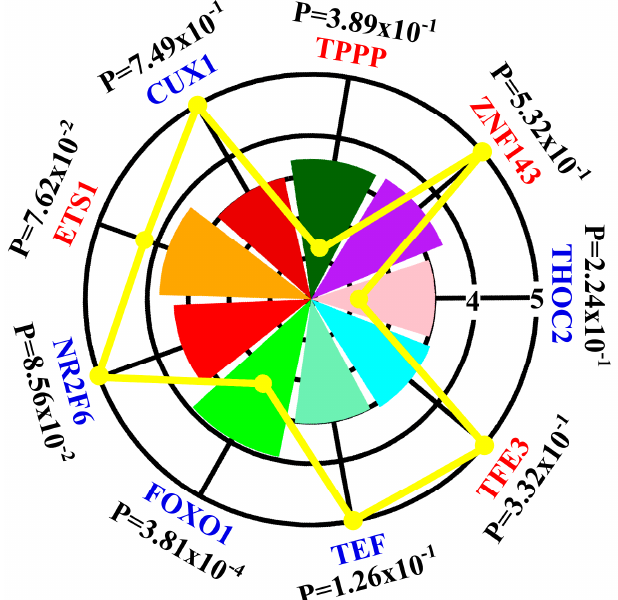
Figure 3. Graphical representation of the iRegulon analysis results. Each chart slice corresponded to a transcription factor identified by iRegulon whose radius was associated normalized enrichment score. The color of the transcription factor indicated upregulation (red) or downregulation (blue) in RNA-seq data and the yellow line showed corresponding absolute values of fold change in RNA-seq data. P values indicated results of validation with GSE1919. For example, FOXO1 is one transcription factor identified by iRegulon which was downregulated (blue color) with fold change –2.38 (yellow line) in RNA-seq and normalized enrichment score 3.92 (green slice). Validation with GSE1919 yielded P value of 3.81 × 10 − 4 .